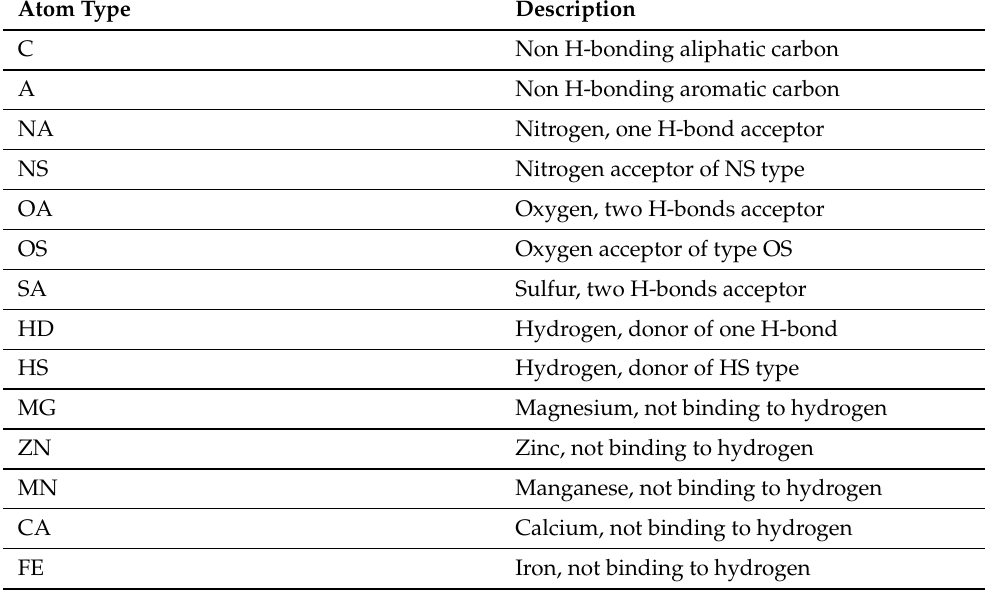
Table 1. Chosen types of atoms according to their chemical properties.